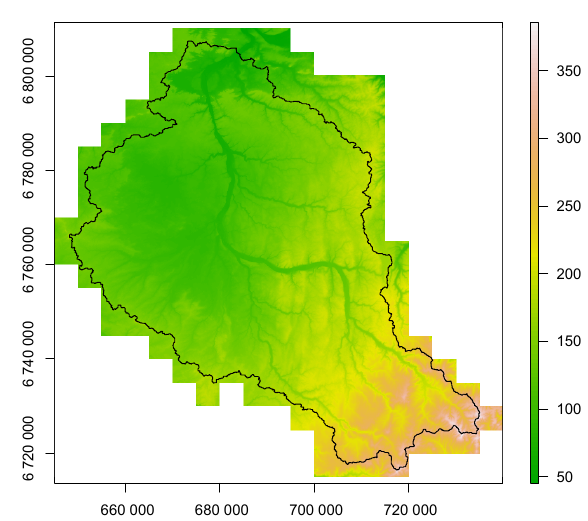
Figure 5. 5m depressionless DEM used in this study. Elevations go from 45 to 390m. Corrections have been applied so that each pixel flows to the